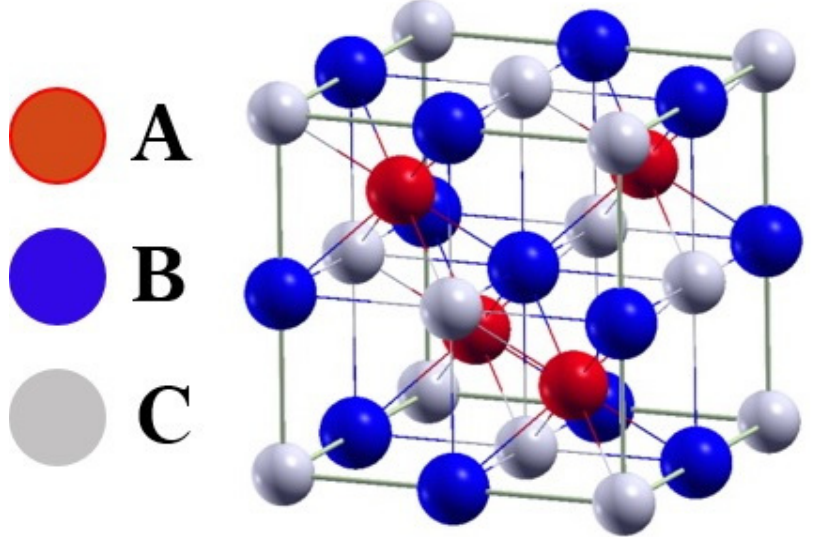
Figure 1. Full Heusler alloy structure model [19].